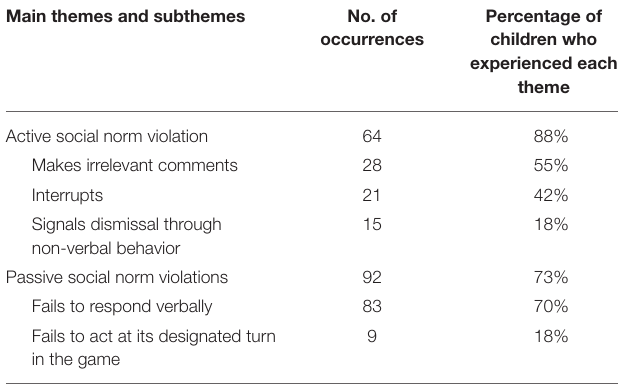
TABLE 1 | Overview of themes and subthemes derived from the thematic analysis. Research question